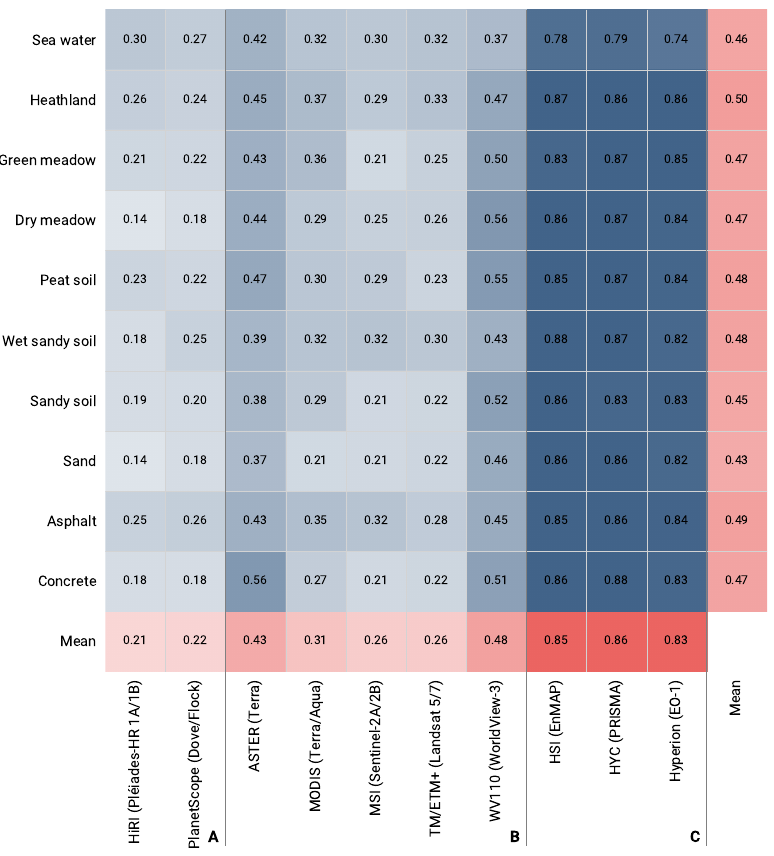
Figure 8. Macro F1 scores in dependence of sensor and background surface using RF. ( A ) Multispectral VNIR sensors, ( B ) multispectral VNIR/SWIR sensors, and ( C ) hyperspectral sensors. No noise was added to the simulated reflectance